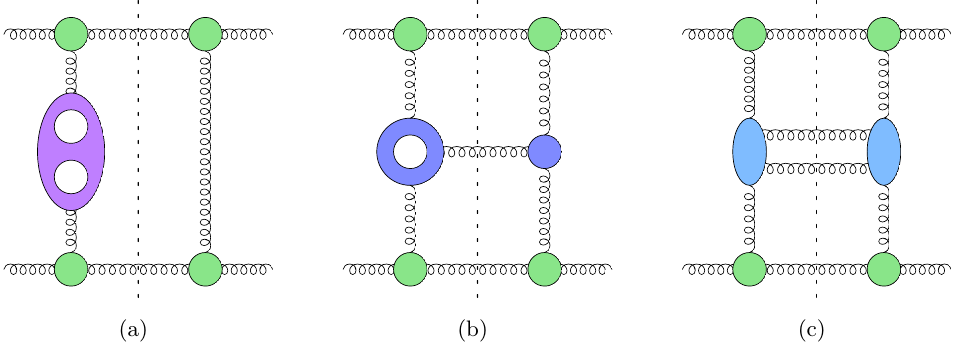
Figure 2 . Interference diagrams which contain the building blocks required for constructing the BFKL equation at NLL accuracy: (a) gluon Regge trajectory at two loops; (b) one-gluon central- emission vertex at one loop; (c) two-gluon central emission vertex at tree